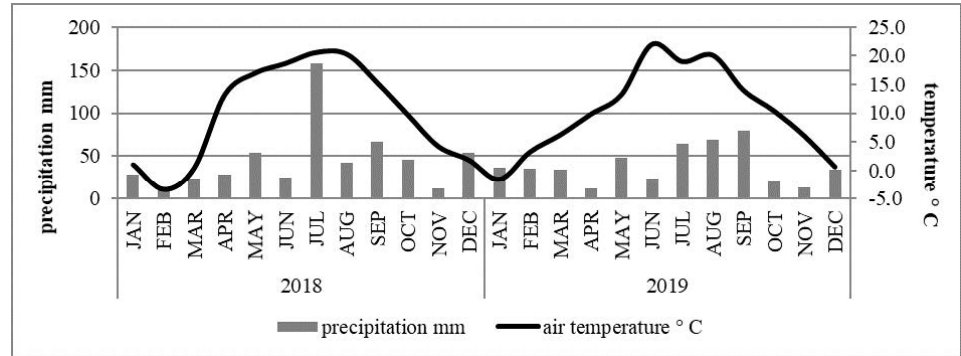
Figure 1. Monthly precipitation totals and temperature in 2018 and 2019.